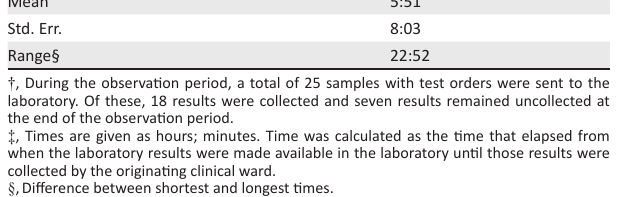
TABLE 3: Result reporting turnaround time from a 24-hour quality audit ( n = 18). † Variable